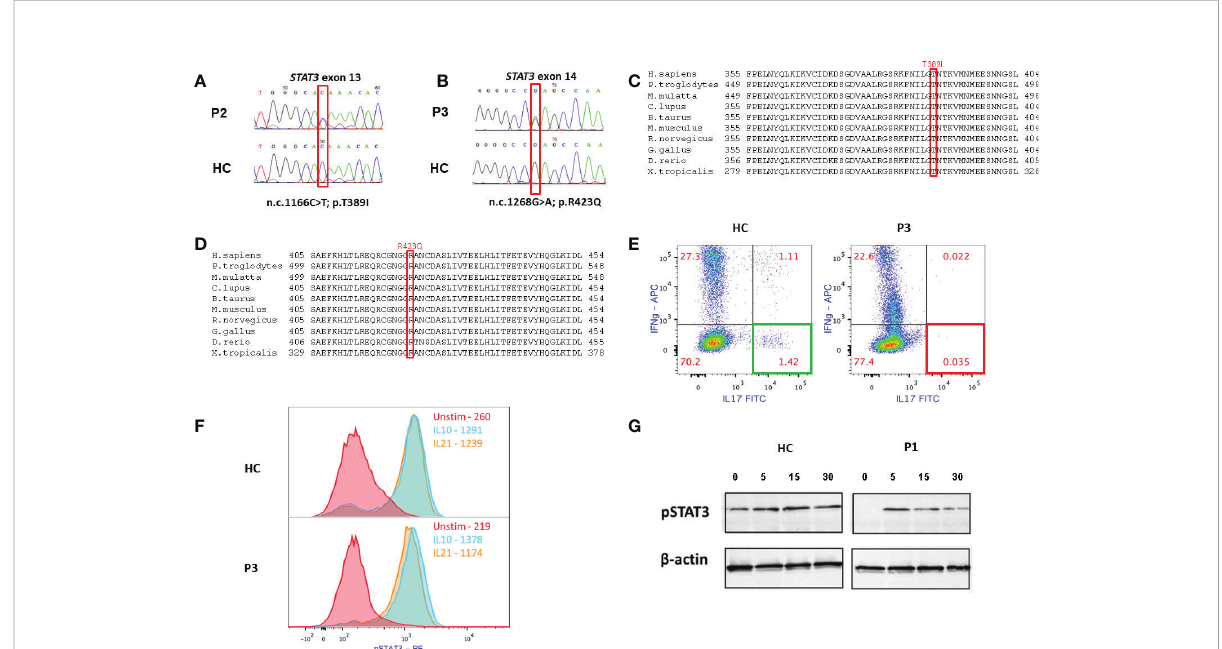
FIGURE 2 Immune and genetic analyses of the patients. (A, B) Sanger sequencings of the STAT3 variants of P2 and P3, respectively (HC- healthy control). (C, D) STAT3 variants in P1-P2 and P3, respectively, are in evolutionary preserved sites. (E) Overnight stimulation of PBMC of P3 with phorbol myristate acetate (PMA) and Ionomycin shows normal production of interleukin (IL)-17 in HC CD4 + T cells (left) and near absent IL-17 production in the patient ’ s CD4 + T cells. (F) P3 ’ s cells were stimulated with either IL-10 (10ng/mL) or IL-21 (100ng/mL) for 20 minutes. Cells were then fi xed, permeabilized and stained for phosphorylated (p) STAT3 Y705. Both HC ’ s and P3 ’ s CD4 + T cells showed normal STAT3 phosphorylation, as can be expected in cases of variant located at the DNA binding domain (DBD). (G) Immunoblotting of P1, demonstrating levels of pSTAT3 in T=0,5,15, and 30 minutes following IL-6 stimulation. While there might be decreased expression of pSTAT3 at baseline, P1 ’ s cells did show STAT3 phosphorylation following stimulation, which is compatible with location of the STAT3 variant in the